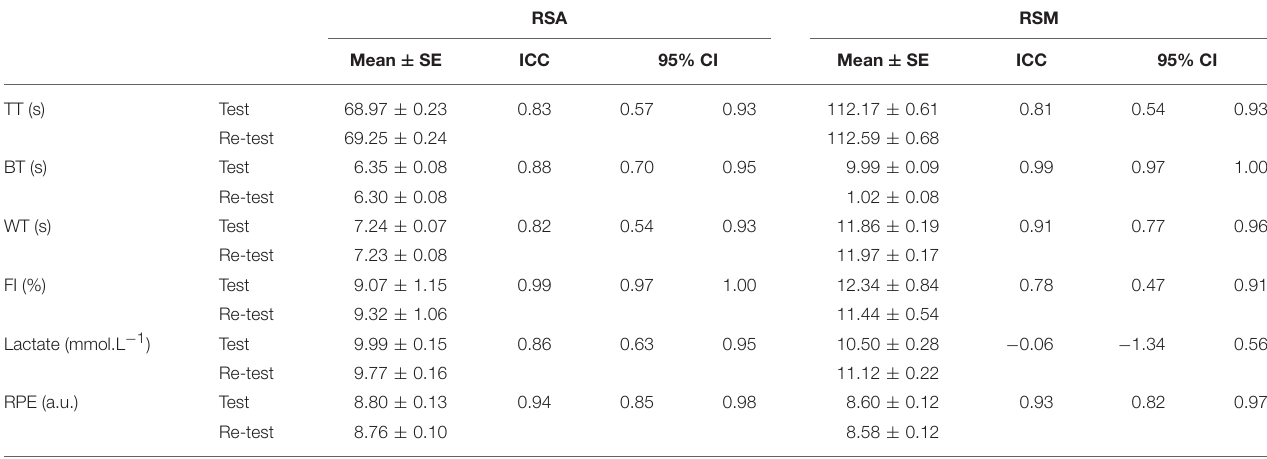
TABLE 2 | Reliability of measurements in RSA and RSM using ICC.